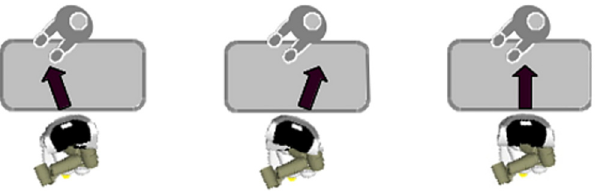
Fig 5. Experimental Setup — Showing the movements of the actor and the respective movements of the robot for each condition. (Left to right: positive synchronised behaviour, negative synchronised behaviour, no